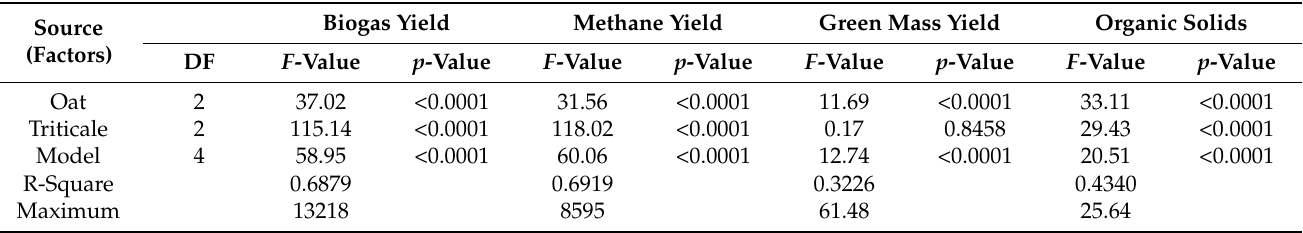
Table 7. Analyses of variance for the models of the biogas, methane, green mass and organic solids yields, for experimental factor oat ( X 1 ) and triticale ( X 3 ). Data included for both years ( n = 8).